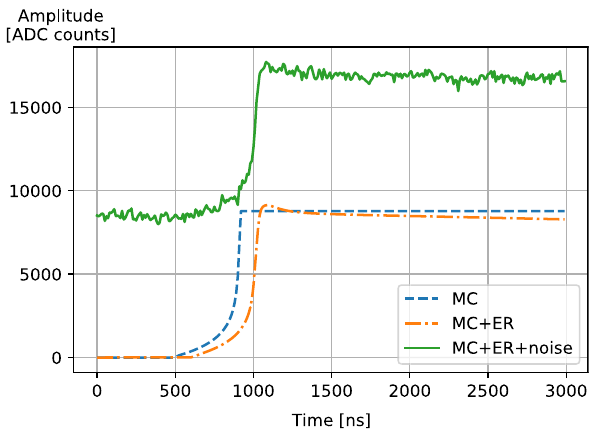
Fig. 15 Implementation of the preamplifier response (ER) and the addition of electronic noise to the simulated pulses (MC). The blue dashed line represents the calculated pulse and the orange dashed the convolution of pulse with the preamplifier response. After adding the noise (recorded separately) one gets the final shape of the pulse